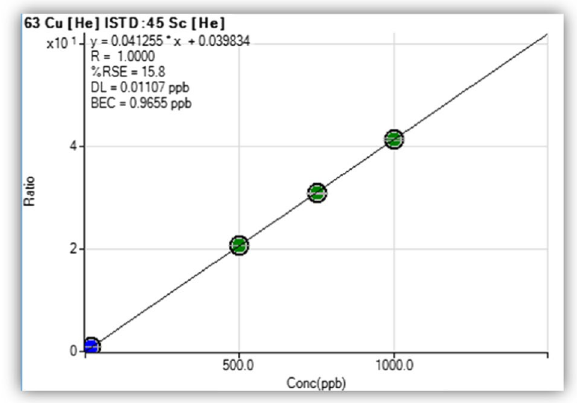
Fig. 3 Graph of copper calibration curve